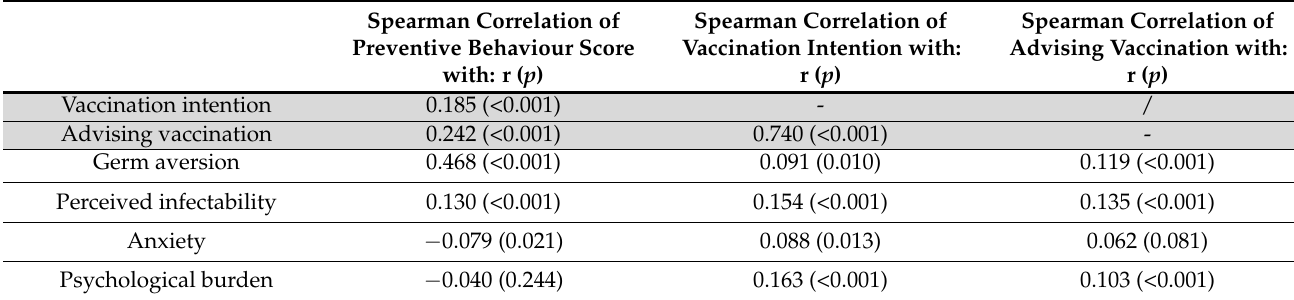
Table 3. Correlation among preventive measure scores (shaded fields) and between preventive measure scores and perception scores (perceived infectability, germ aversion, psychological burden, and anxiety). Spearman Correlation of Spearman Correlation of Spearman Correlation of Preventive Behaviour Score Vaccination Intention with: Advising Vaccination with: r ( p ) r ( p )